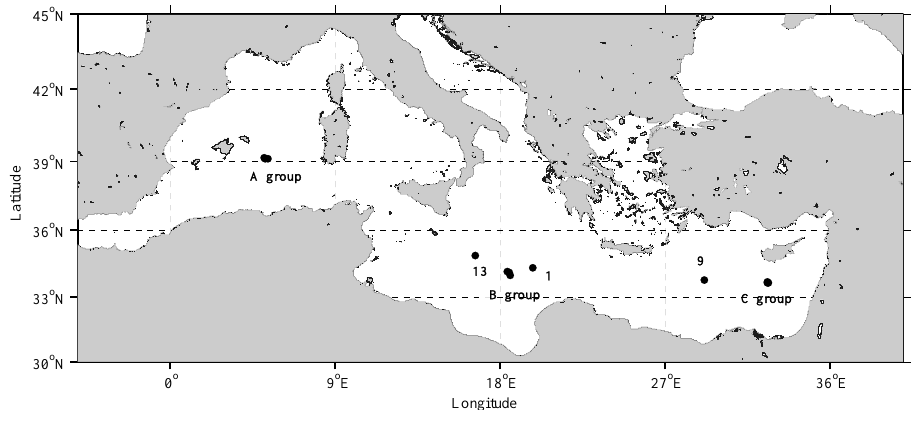
Fig. 1. Map of the sampled stations. POCp and DOCp measurements were conducted in a total of 12 stations along the BOUM transect. Three stations were occuppied inside the anticyclonic eddies sampled in each region (A, B, C), two in the Ionian Sea, and one in the Levantine basin.